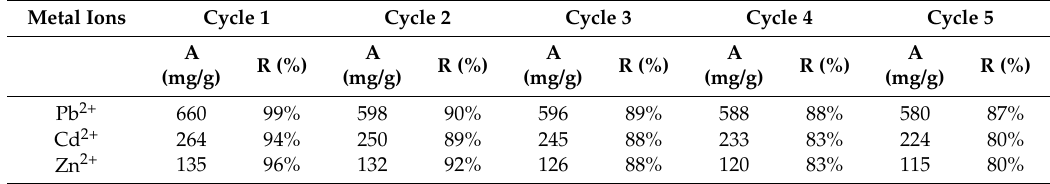
Table 2. The desorption and regeneration properties of